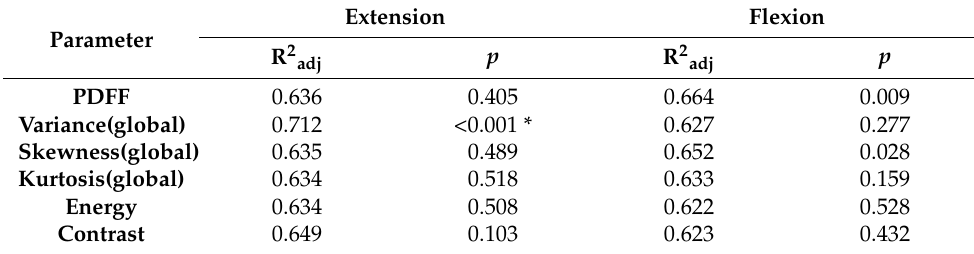
Energy Contrast 0.649